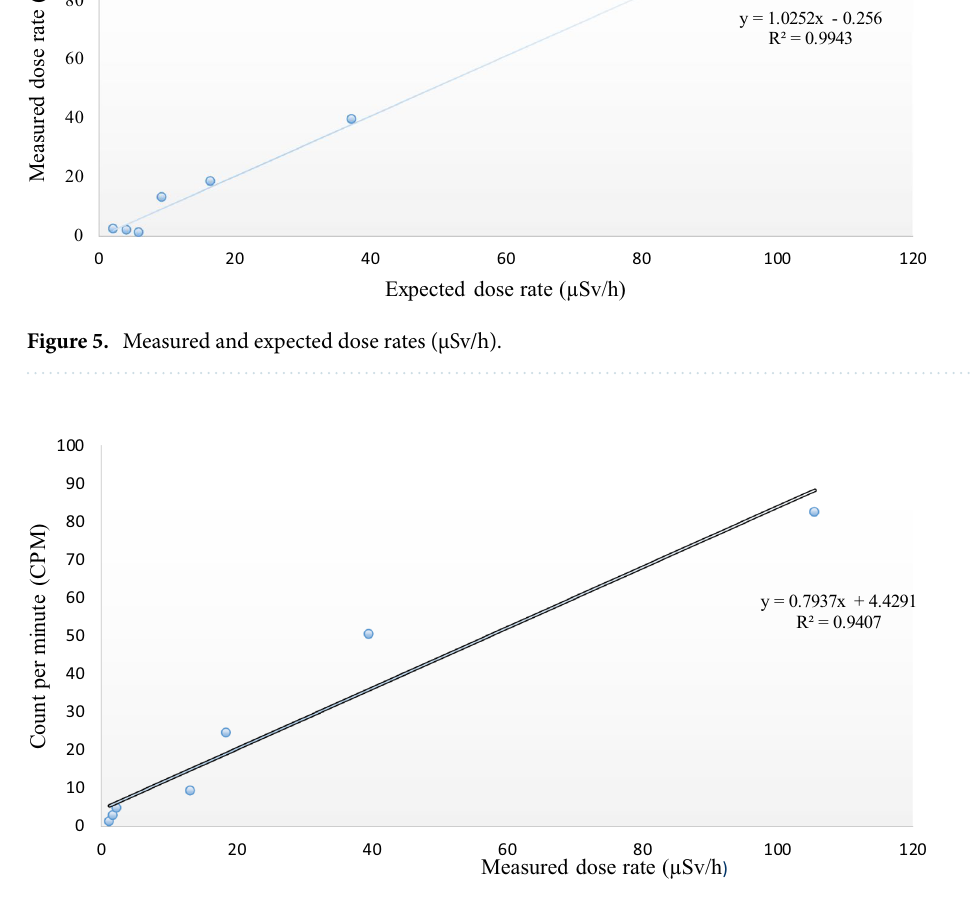
Figure 6. Relationship between count per minute (CPM) and measured dose rate